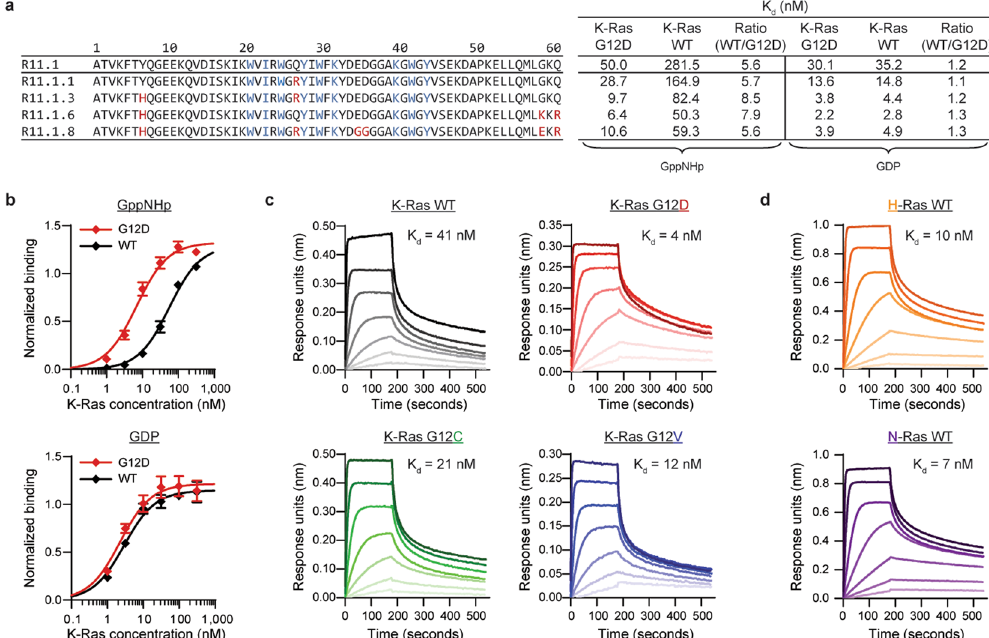
Figure 1. Engineered Sso7d protein selectively binds mutant K-Ras. ( a) Amino acid sequences of parental binder R11.1 and affinity-matured clones. The nine residues of the Sso7d binding surface are depicted in blue; R11.1 framework mutations are shown in red. Dissociation constants (K d ) obtained from yeast surface display (YSD) titrations detected using flow cytometry are given on the right. ( b) YSD titrations of R11.1.6 with K-Ras loaded with GDP or the non-hydrolyzable GTP analog GppNHp. Error bars represent SEM of n =